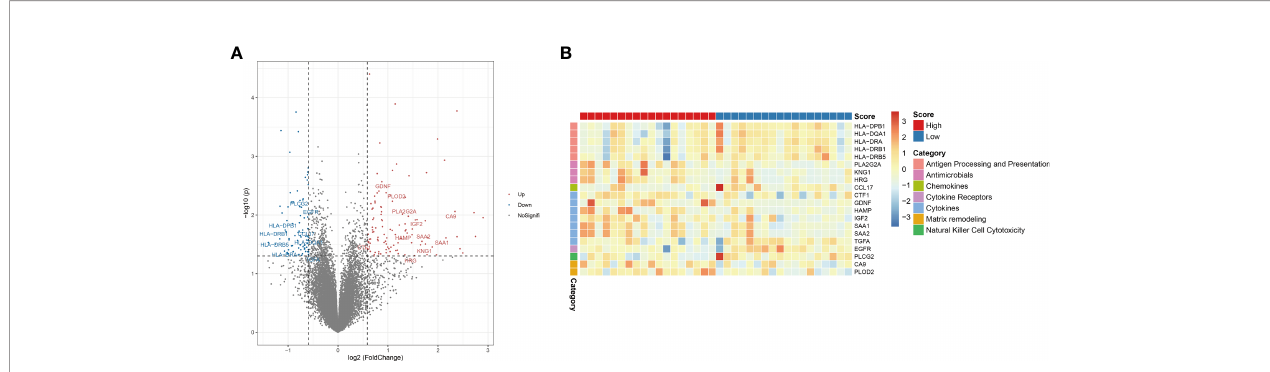
FIGURE 6 | Hypoxia-related risk scores reveal differences in tumor immune microenvironment characteristics. (A) The volcano plot of different expression immune- related genes. (B) The heatmap of immune-related genes and different immune categories in the high- and low-risk